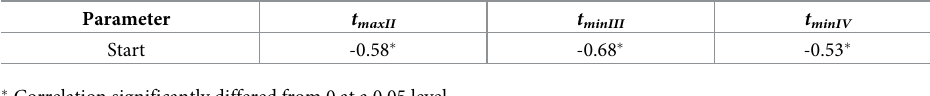
Table 1. Spearman correlation between model predictors and the start